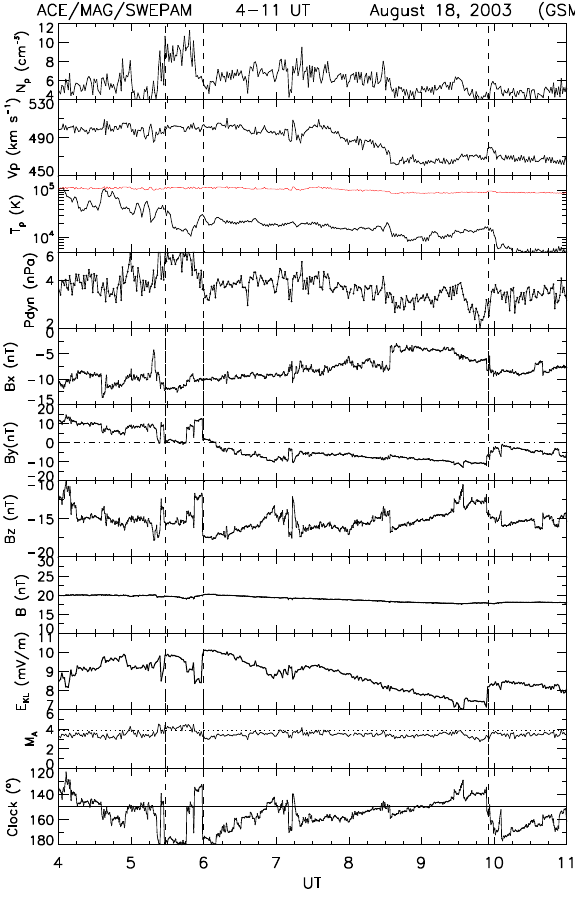
Figure 2. Interplanetary data from the ACE satellite during the interval 04:00–11:00UT. Panels from top to bottom show proton density ( N p ; cm − 3 ); bulk speed ( V p ; kms − 1 ); proton temperature T p (K; in red the expected temperature after Lopez and Freeman, 1986); dynamic pressure P dyn (nPa), magnetic field components B x , B y , and B z in GSM coordinates; the field strength B (nT); the Kan–Lee merging electric field, E KL (mVm − 1 ); the Alfvén Mach number, M A ; and the clock angle of the magnetic field ( ◦ ). The three most geoeffective (see E KL ) magnetic field directional discontinu- ities (DDs) are marked by vertical dashed